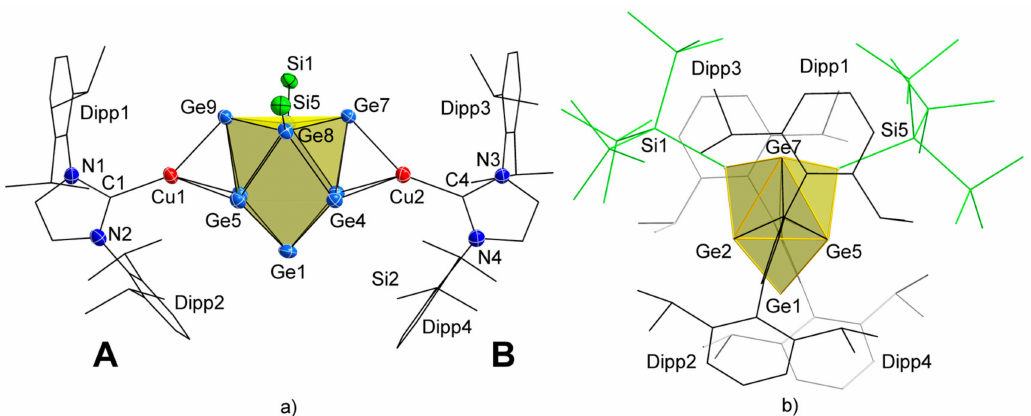
Figure 5. Two perspectives of the molecular structure of compound 2 . ( a ) Front view of 2 revealing the C 2 v -symmetry of the cluster. Displacement ellipsoids are shown at a 50 % probability level. For clarity, hydrogen atoms, co-crystallized toluene molecules, and the TMS groups are omitted. The two [NHC Dipp Cu] + moieties are labelled as A and B ; ( b ) View along the Cu1–Cu2 vector showing the orientation of the two NHC Dipp moieties and the silyl substituents of the [Ge 9 ] cluster. All ligands are pictured as wire frames. For clarity, the NHC Dipp ligand in the background is pictured in grey and the silyl groups are shown in green. Selected bond lengths and angles are summarized in Table 2 and in the Supporting Information (Table SI 2).